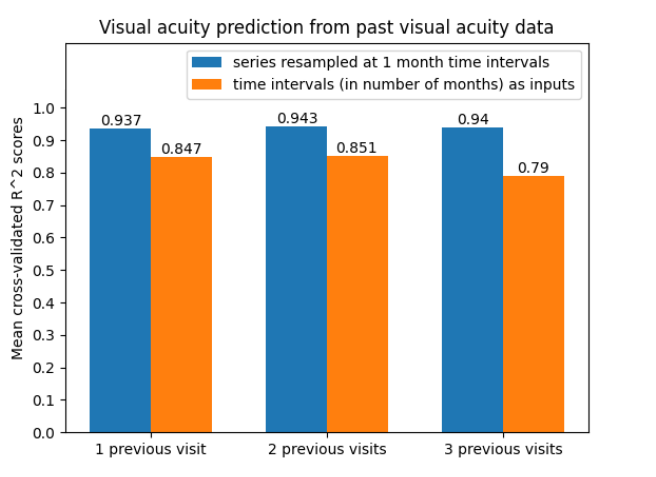
Figure 10. Average cross-validated R 2 scores when predicting future visual acuity only from previous visual acuity data.